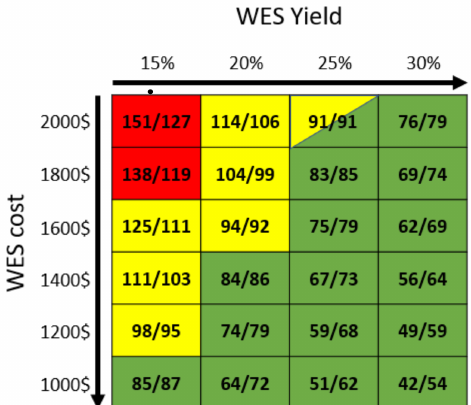
Figure 1. Incremental cost-effectiveness ratio (ICER) of WES alone and of CMA + WES strategies for different WES yields and costs. The ICERs of the WES strategy (numbers on the left) and of the CMA + WES (numbers on the right) strategy are depicted for different WES yields (X-axis) and costs (Y-axis). Cell colors indicate the most cost-effective strategy for each WES yield–cost combination (red, CMA alone; yellow, CMA + WES; green, WES